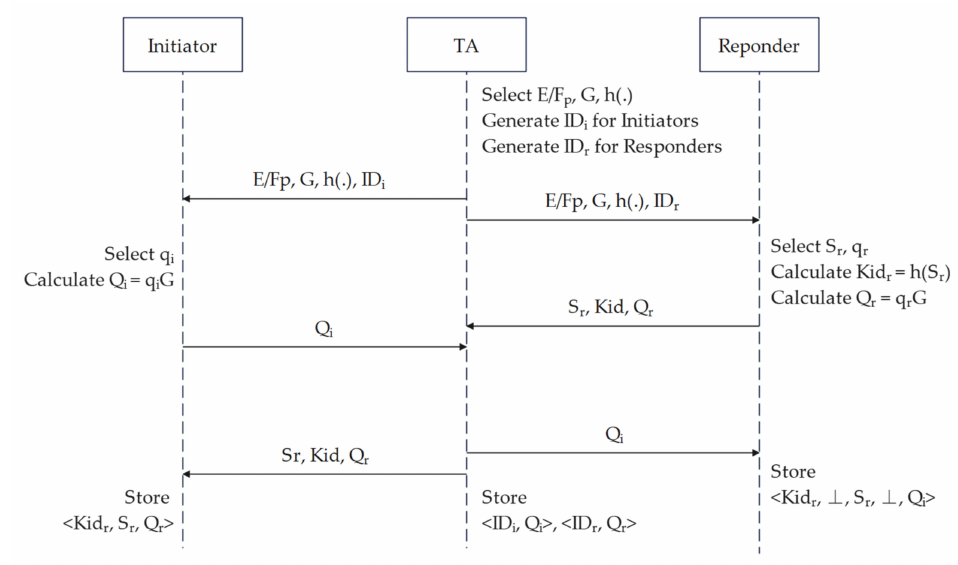
Figure 2. Initialization and registration